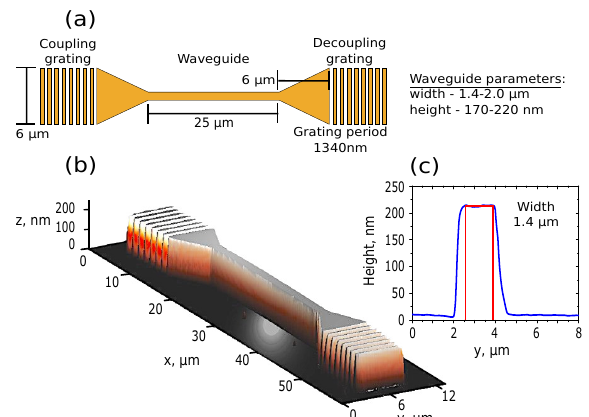
Figure 3. ( a ) Schematic view of the fabricated photonic device. The sizes of gratings, triangles and waveguide length were fixed. Waveguide height and width were varied; ( b ) Atomic forece microscopy (AFM) image of manufactured photonic device (sample 2). ( c ) Waveguide cross-section (sample 2).